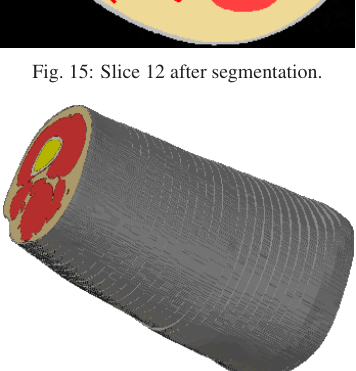
Fig. 15: Slice 12 after segmentation.